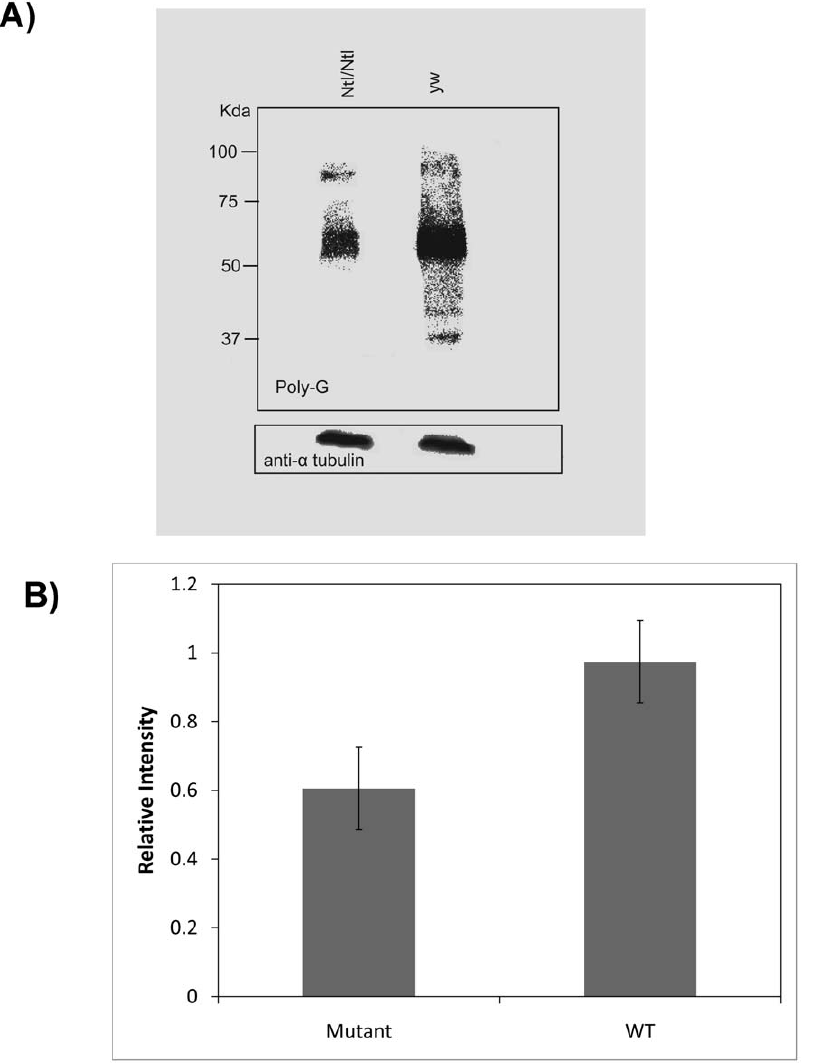
Figure 7. Polyglycylation of tubulin is partially decreased in mutant testes. A)Western Blot of Ntl/Ntl male abdomens compared to + / + (yw) probed with anti Poly-G antiserum. B) Quantitation of 6 independent replicates of the Western analysis of panel A. Bar, standard error of the mean. N=6.